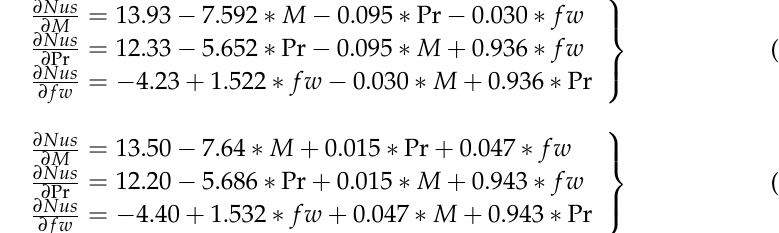
Figure 18. Case-2 residual plot of Nusselt number.